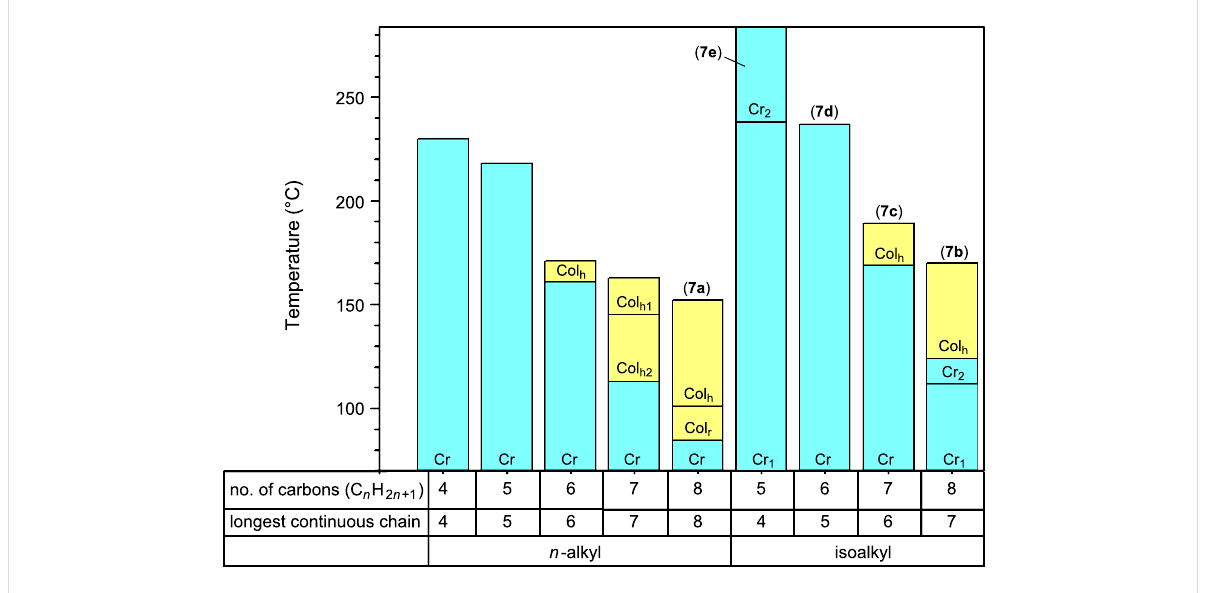
Figure 1: Comparison of the phase behaviours of the α -substituted phthalocyanines with n -alkyl [25] and isoalkyl side chains. The stable ranges for the crystal phases are shown in blue and those of the columnar liquid-crystalline phases in yellow.